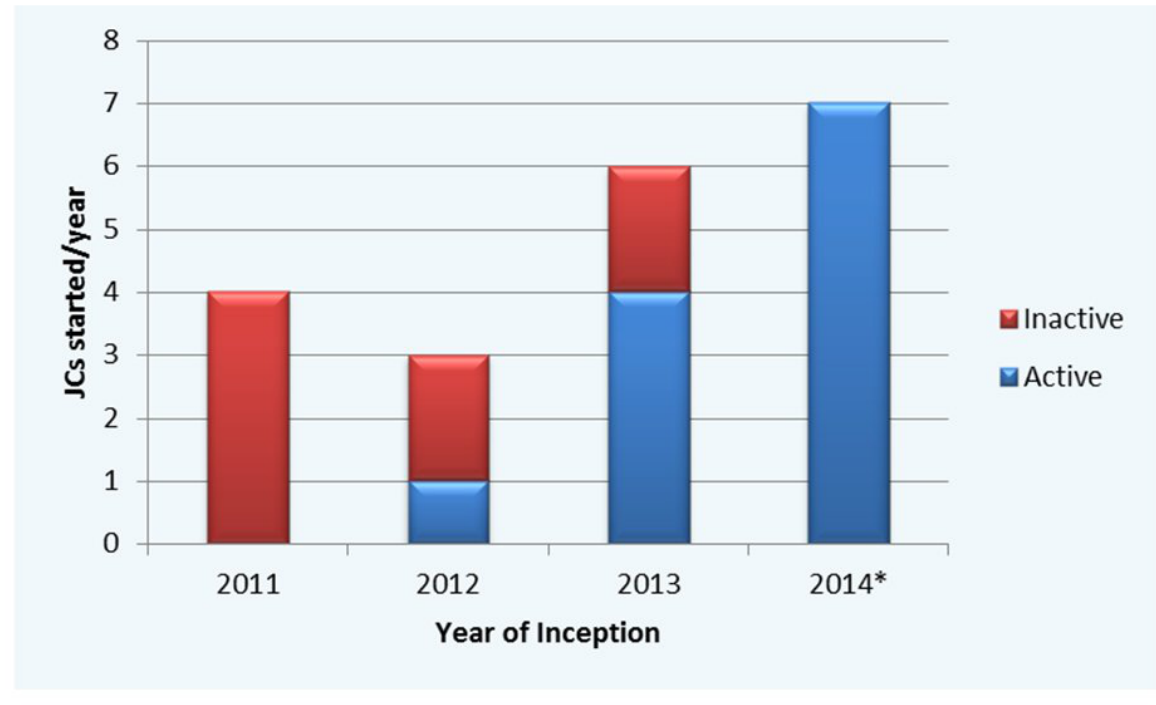
Figure 2. Establishment of journal clubs per year, comparing all journal clubs (blue) with currently active journal clubs (red). 2014 included journal clubs started prior to October